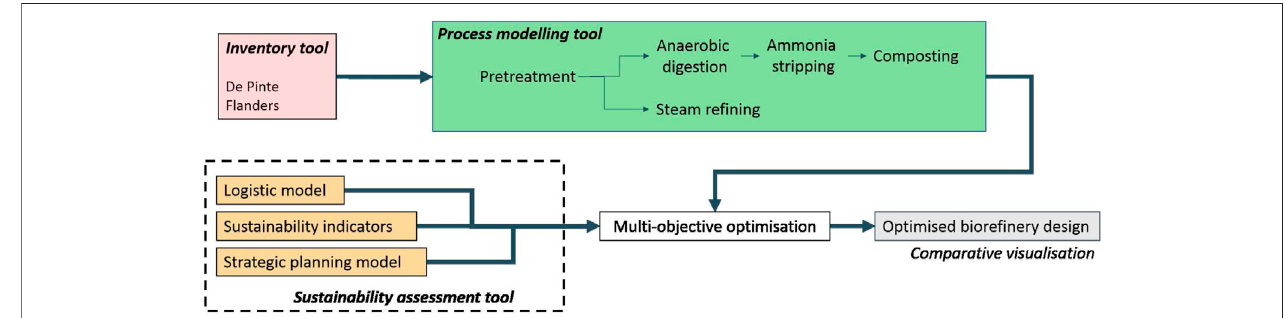
FIGURE 1 | Outline of the proposed decision support tool. This paper focusses on the inventory